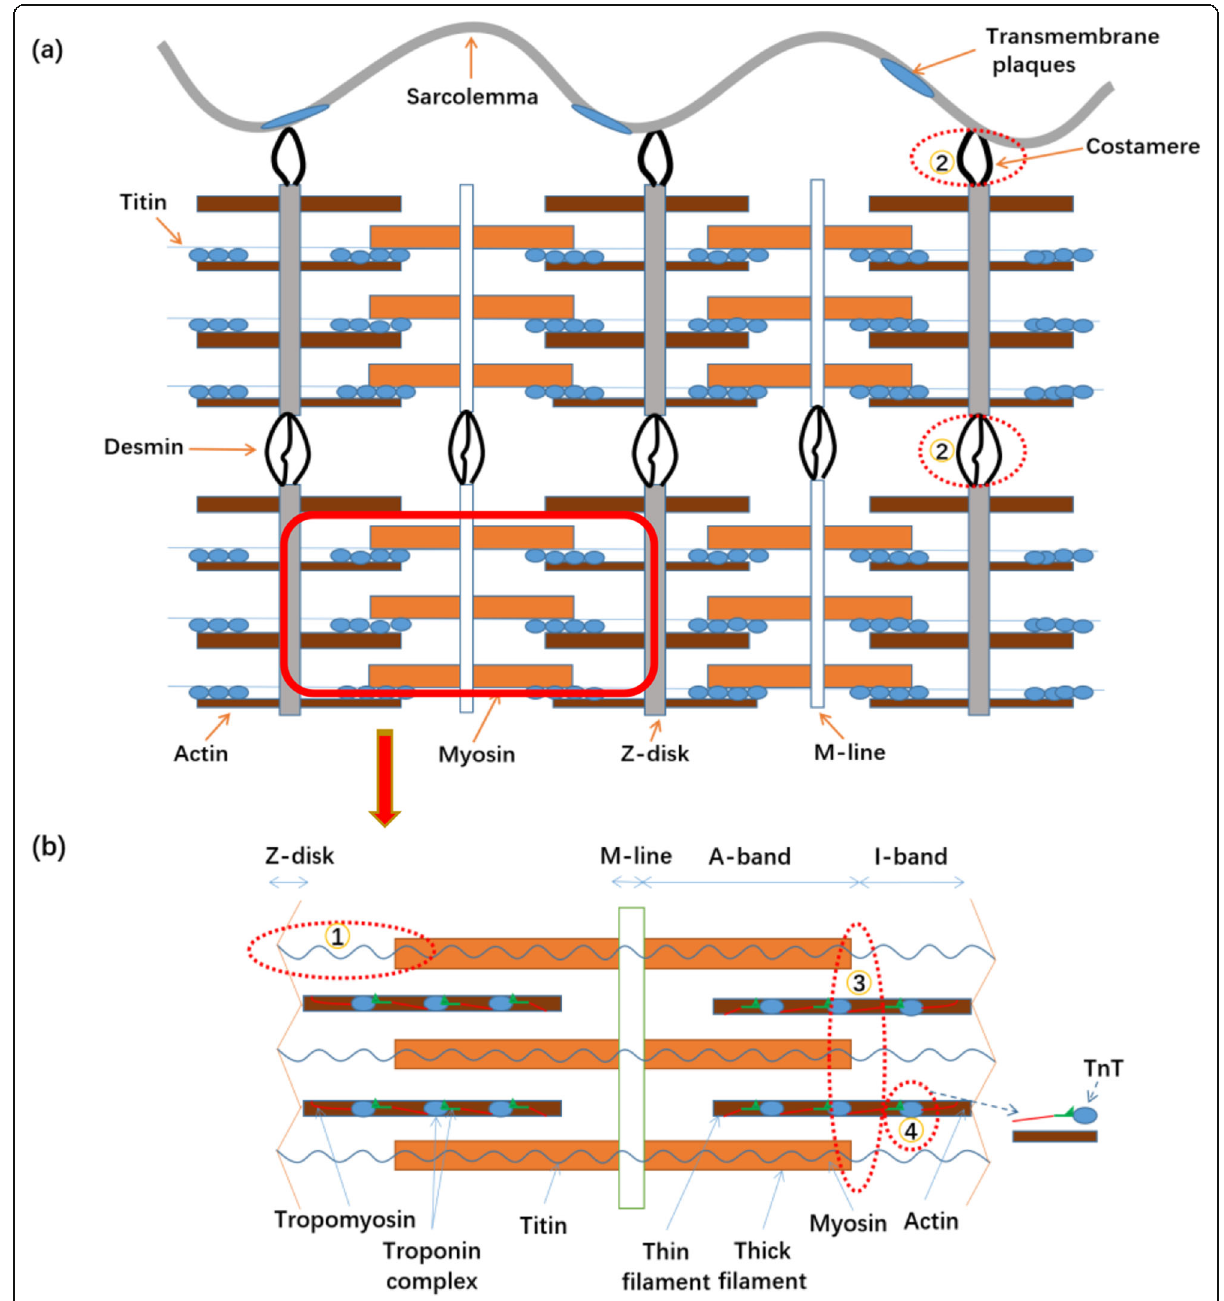
Fig. 3 Whole structure of myofibrils ( a ) and local structure of myofibrils ( b